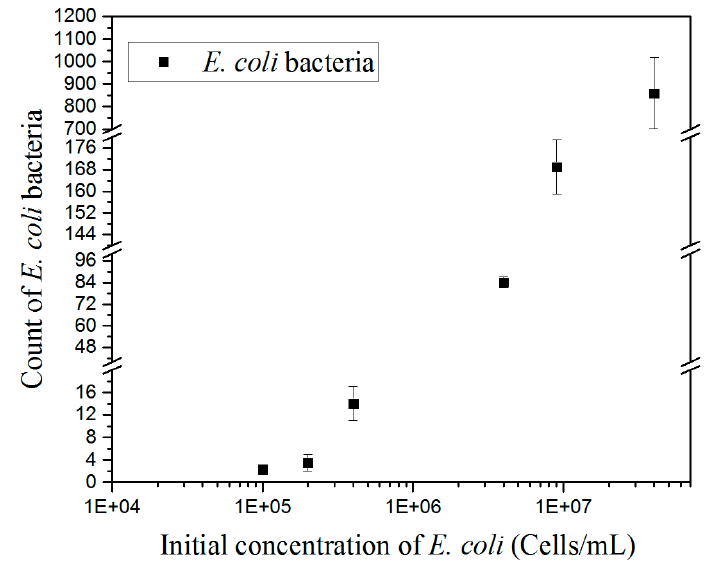
Figure 6. Calibration curve of the count of E. coli bacteria immobilized on the surface after the washing step versus the concentration of cultured E. coli bacteria.